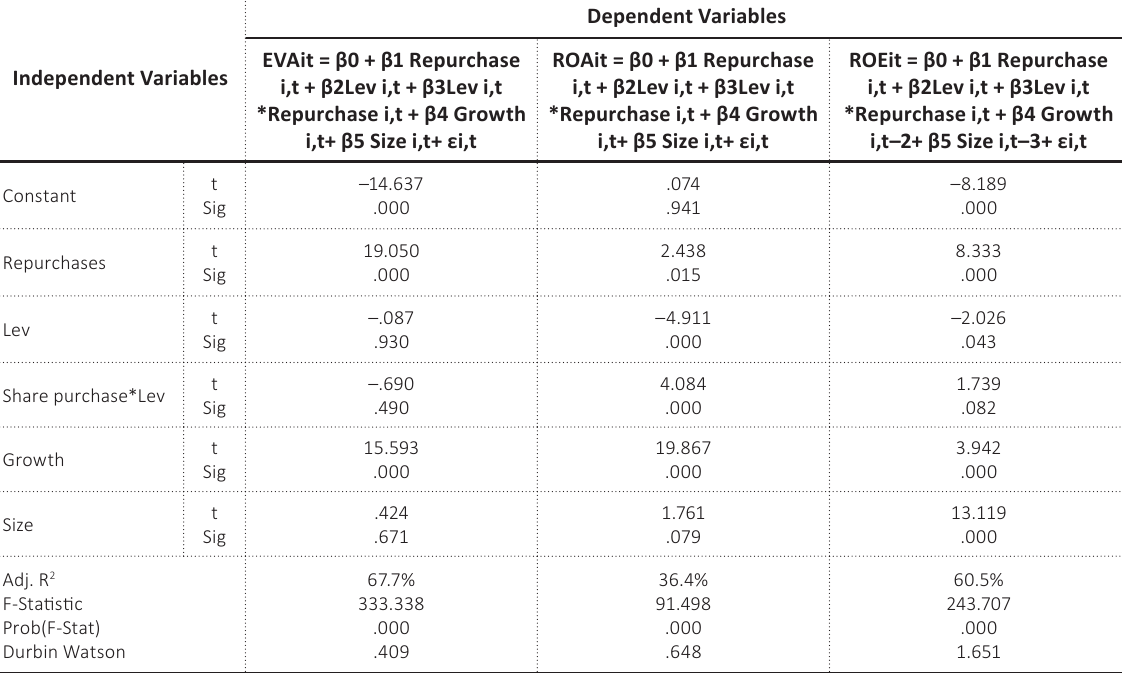
Table 8. The interactive effect of financial leverage per share and share buyback on financial